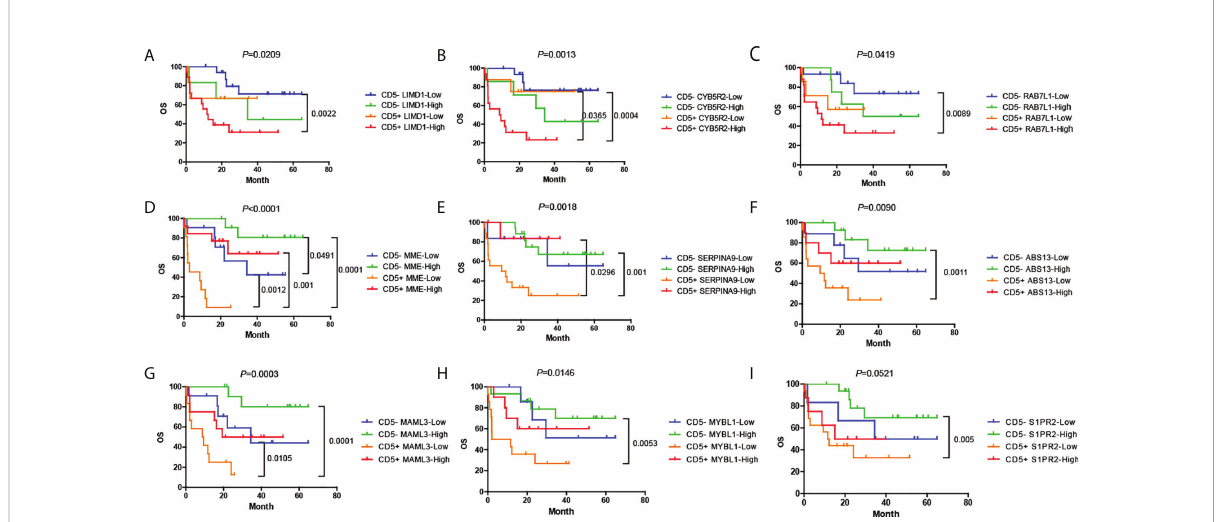
FIGURE 6 (A – I) Distinct prognoses between cases with high or low expression of the nine genes that correlated with OS. Cases were divided according to whether they had high or low expression of each gene by the median mRNA level, and Kaplan – Meier plots are presented for CD5- or CD5+ cases separately. OS, overall survival; PFS, progression-free